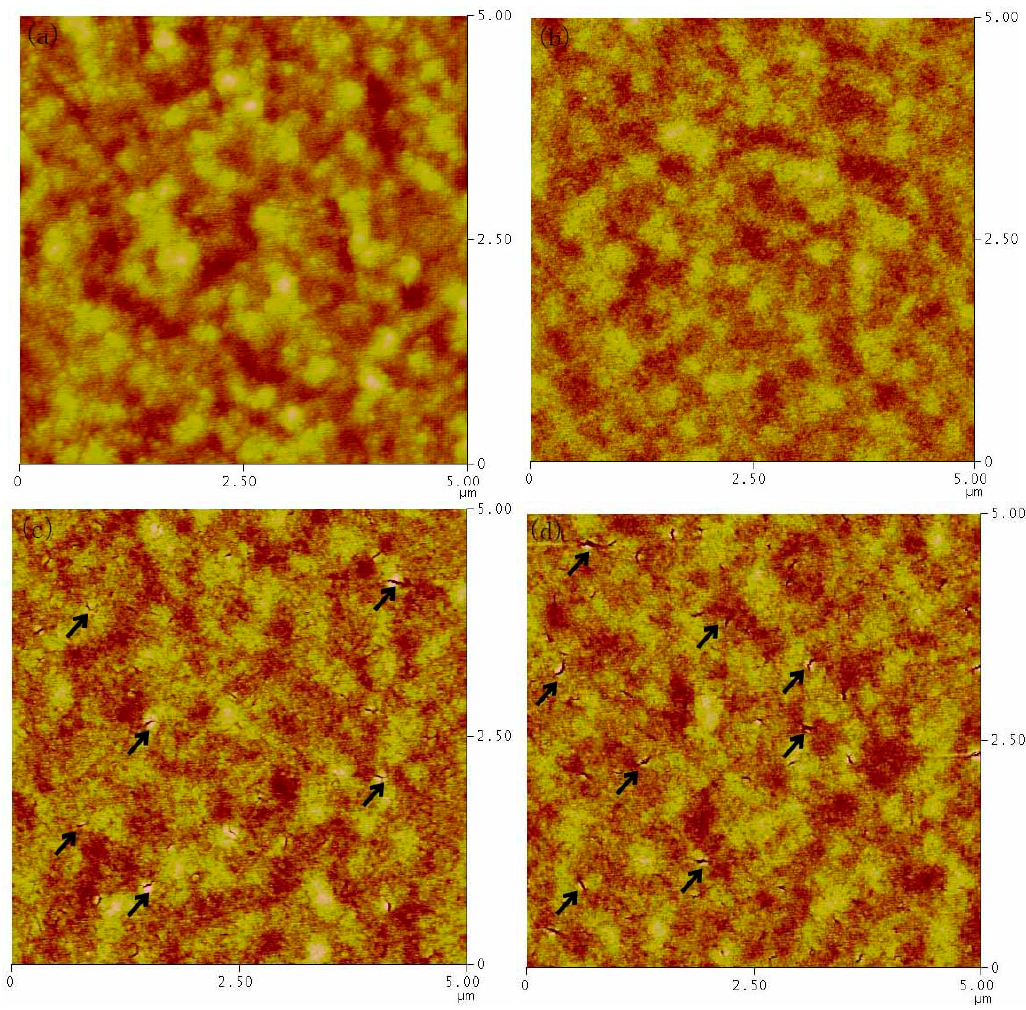
Figure 6. AFM (atomic force microscope) images for PbS CQDs thin film fabricated by using different n-octane/isooctane solvent ( a ) 5% isooctane ( b ) 10% isooctane ( c ) 20% isooctane ( d ) 40% isooctane.